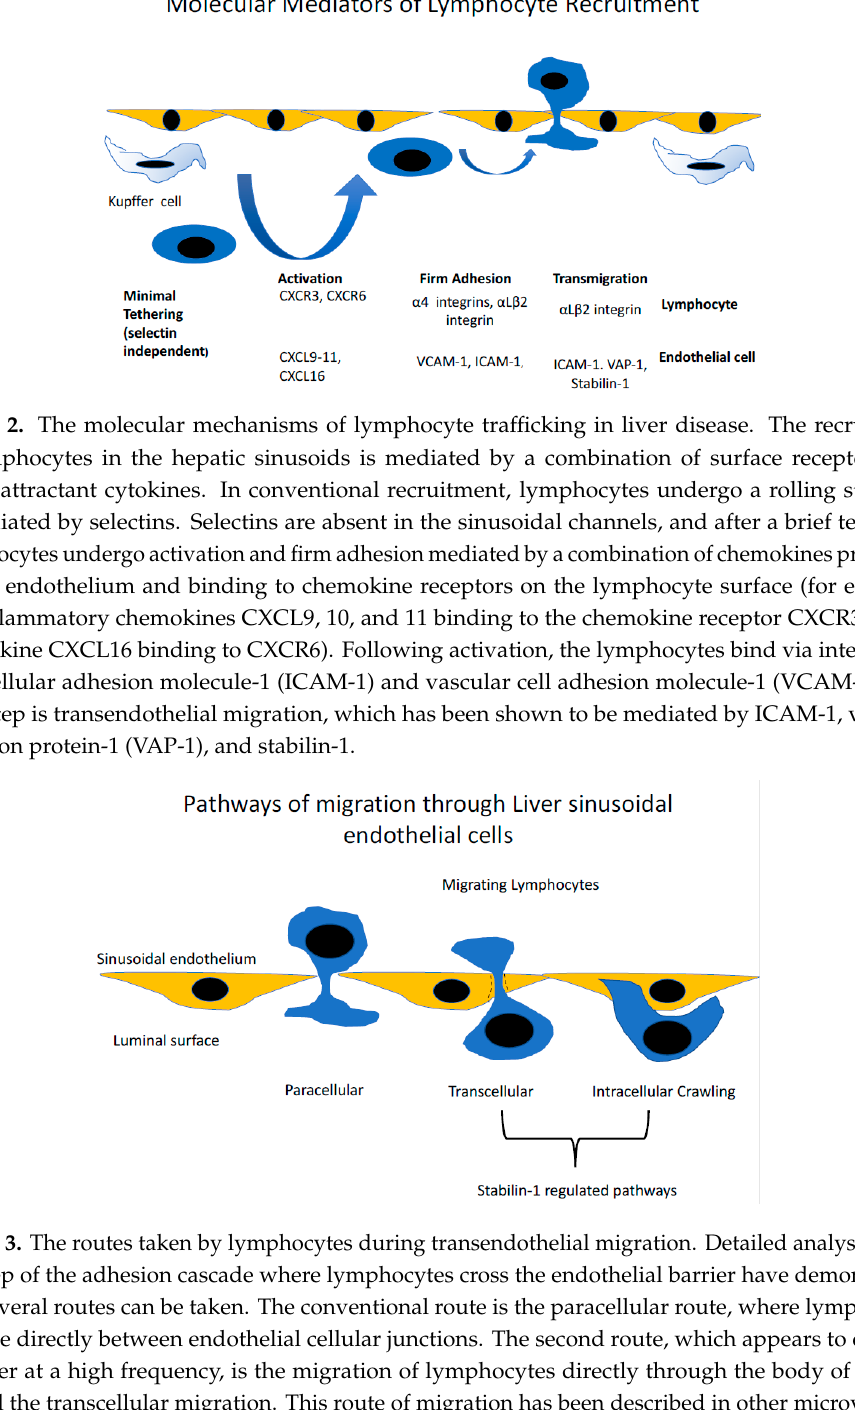
interferon- γ -mediated and were thought to be facilitated by the unique junctional complexes expressed